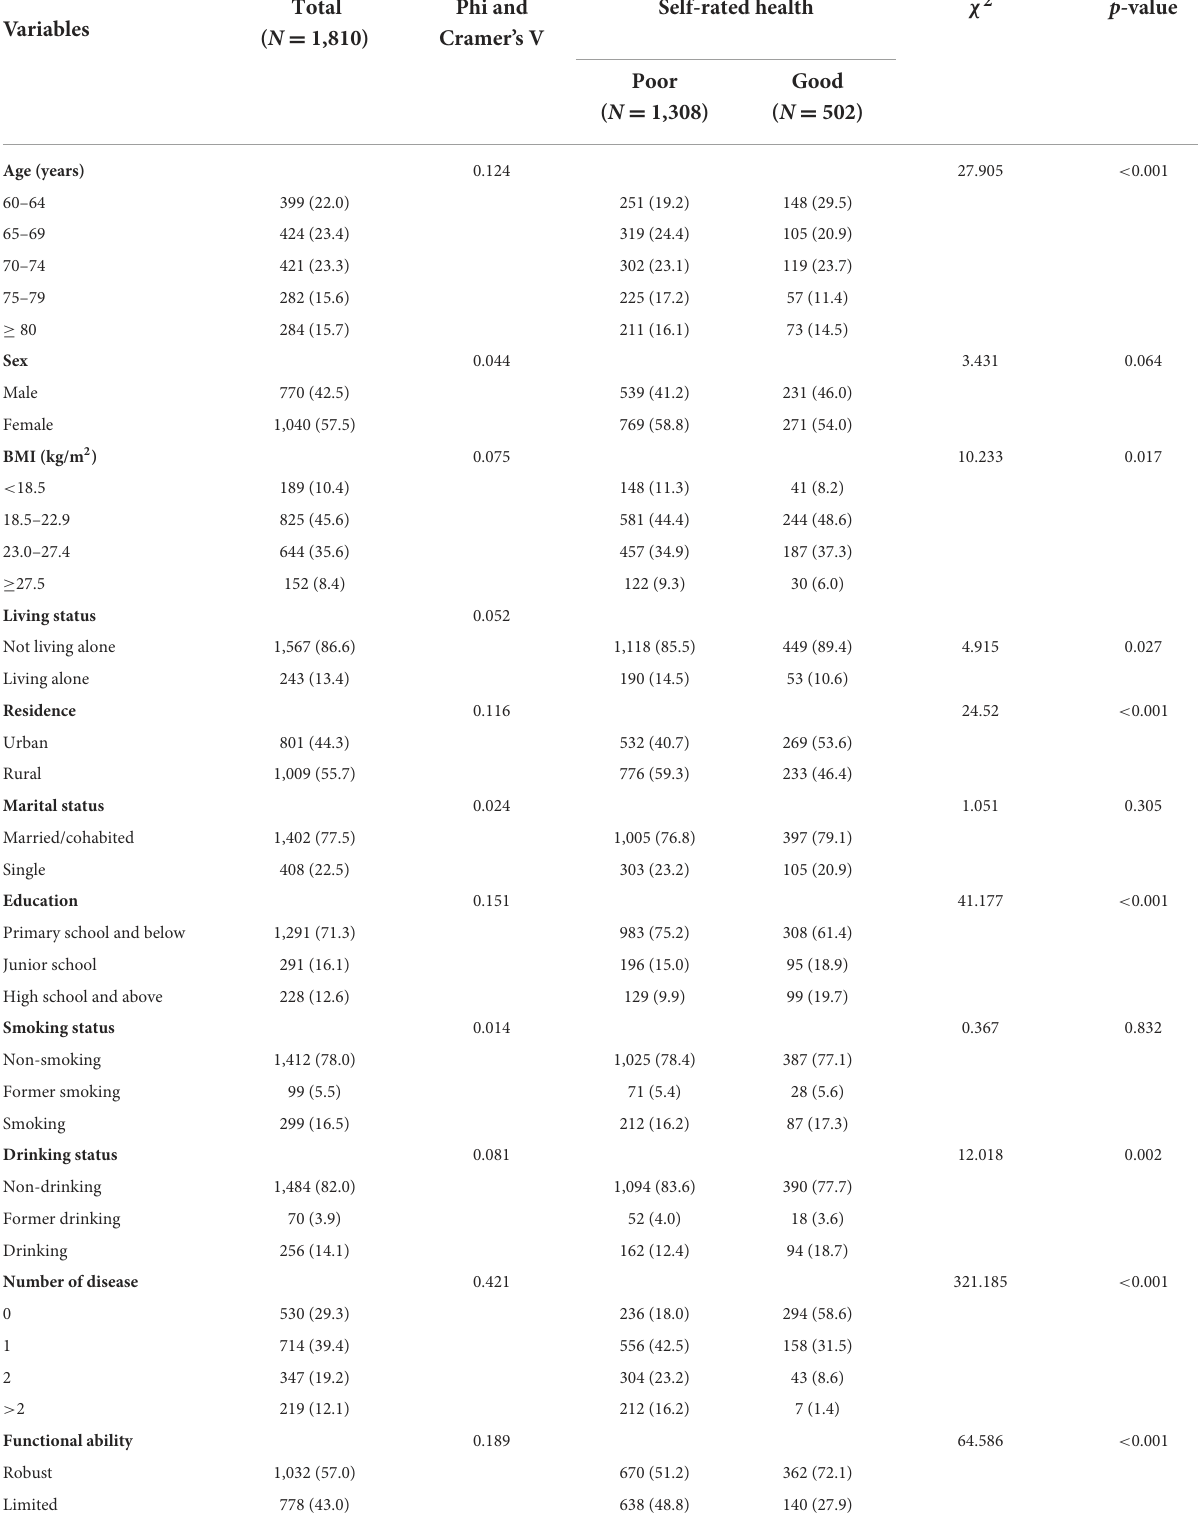
TABLE 1 Characteristics of participants stratified by self-rated health (SRH) status ( N =